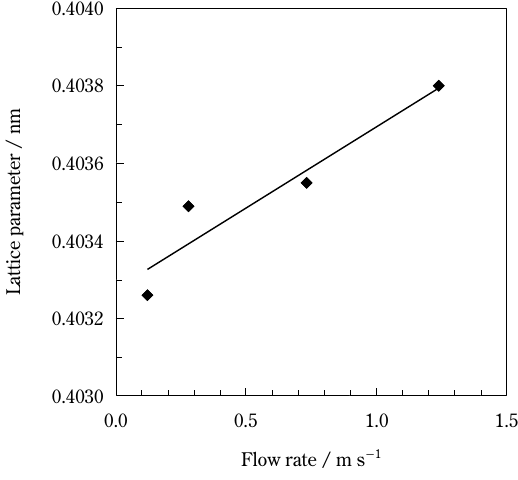
Fig. 8 Effect of mixing condition on the lattice parameter of cubic-BaTiO 3 unit cell prepared by sol-gel method.